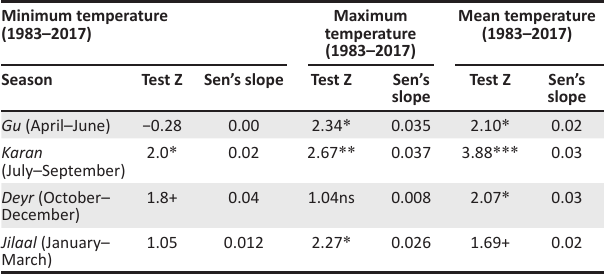
Maximum Mean temperature temperature (1983–2017) (1983–2017)